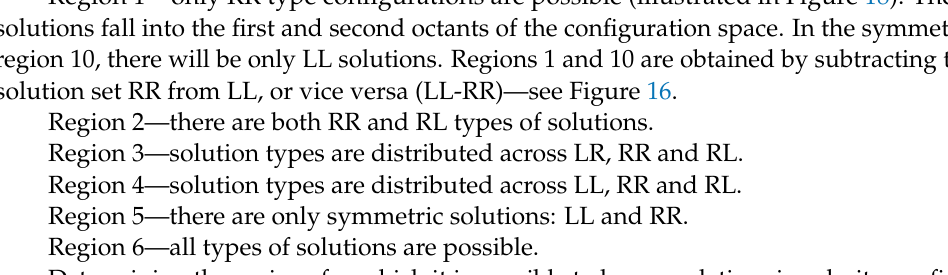
Figure 18. Result of applying the algorithm for point P, located in areas 1 to 6, according to Figure